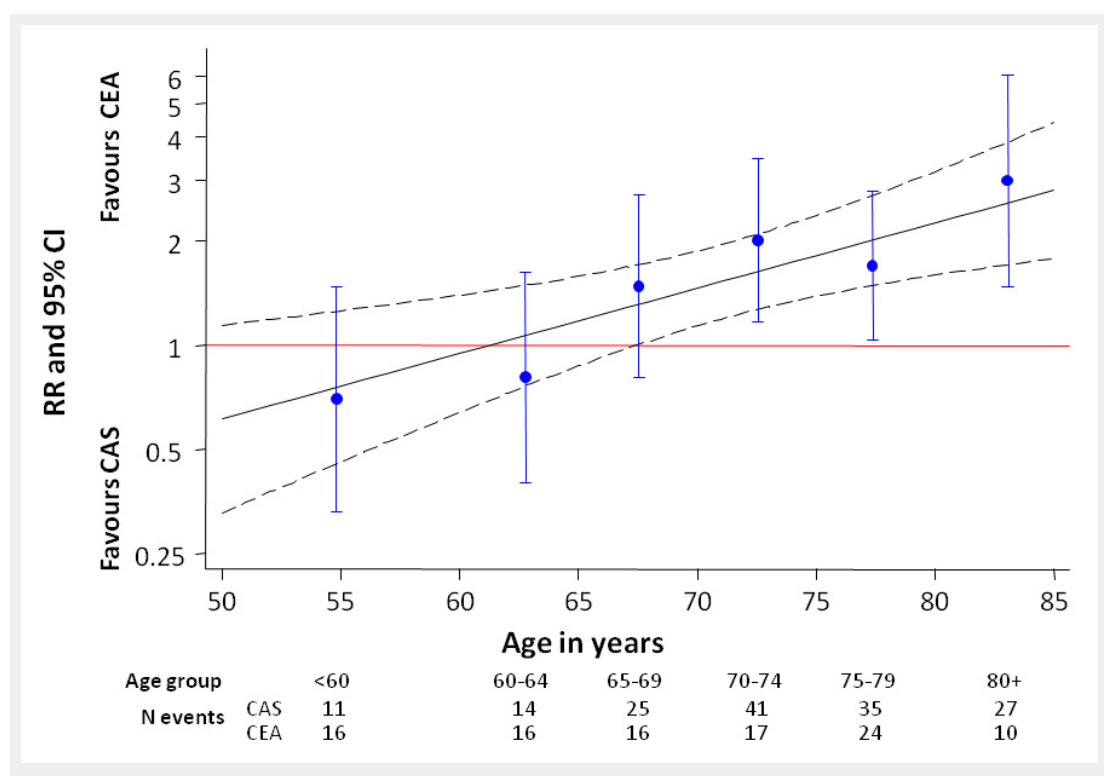
Figure 2 Pooled Individual patient-data meta-analysis of the EVA-3S, SPACE and ICSS trials, comparing primary carotid stenting with endarterectomy for symptomatic carotid stenosis: risk ratio of any stroke or death within 120 days of randomisation according to patient age. (Reproduced from [20]: Bonati LH, Dobson J, Algra A, Branchereau A, Chatellier G, Fraedrich G, et al. Short-term outcome after stenting versus endarterectomy for symptomatic carotid stenosis: a preplanned meta-analysis of individual patient data. Lancet. 2010;376(9746):1062–73. © Elsevier, Oxford, UK. Reprint with kind permission.) CAS =carotid artery stenting; CEA = carotid endarterectomy; RR = risk ratio CAS versus CEA; 95% CI = 95% confidence